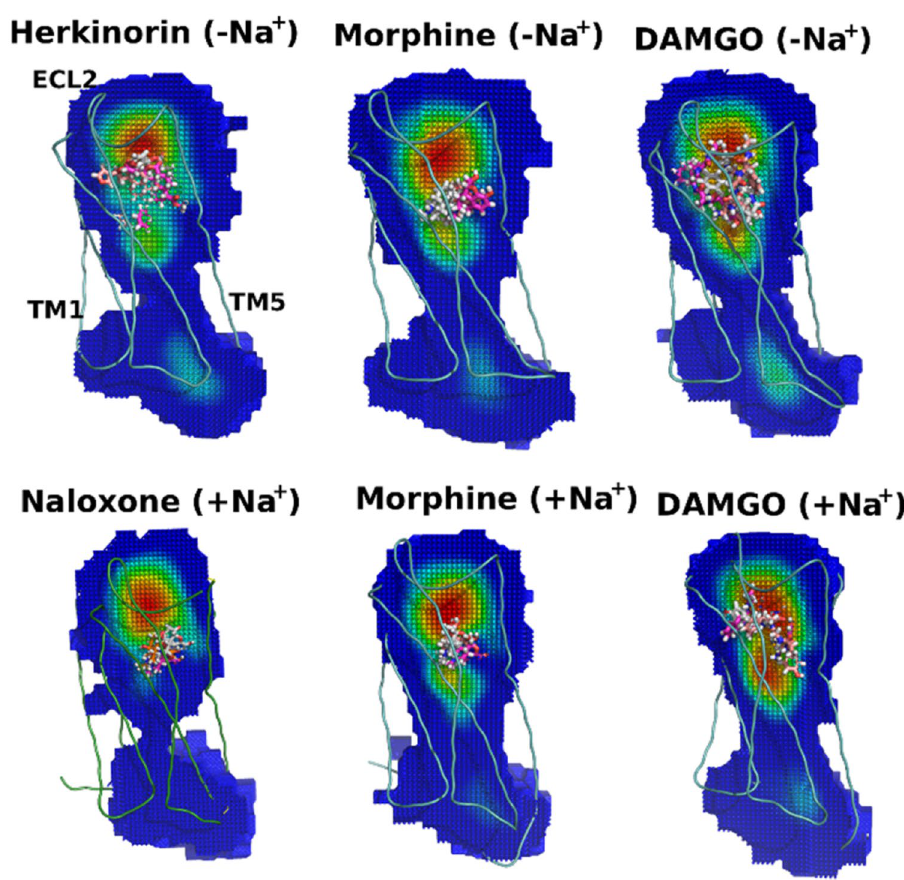
Fig. 3 Cavities and water distribution in μ-OR. Cavities are colored by the possibility of allocating water molecules, red is high, and blue is low. The probability distribution came from all three simulations in each